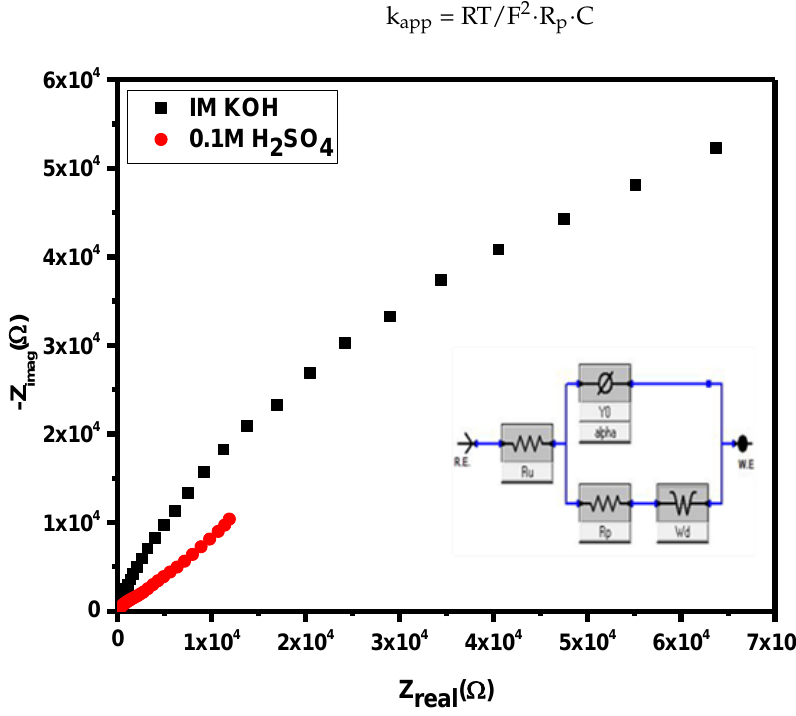
Figure 7. Nyquist plots of Ti 3 C 2 T X /Ag 2 CrO 4 in 1 M KOH and 0.1 M H 2 SO 4. Table 2. Electrochemical parameters estimated from EIS analysis Ti 3 C 2 T x /Ag 2 CrO 4 modified